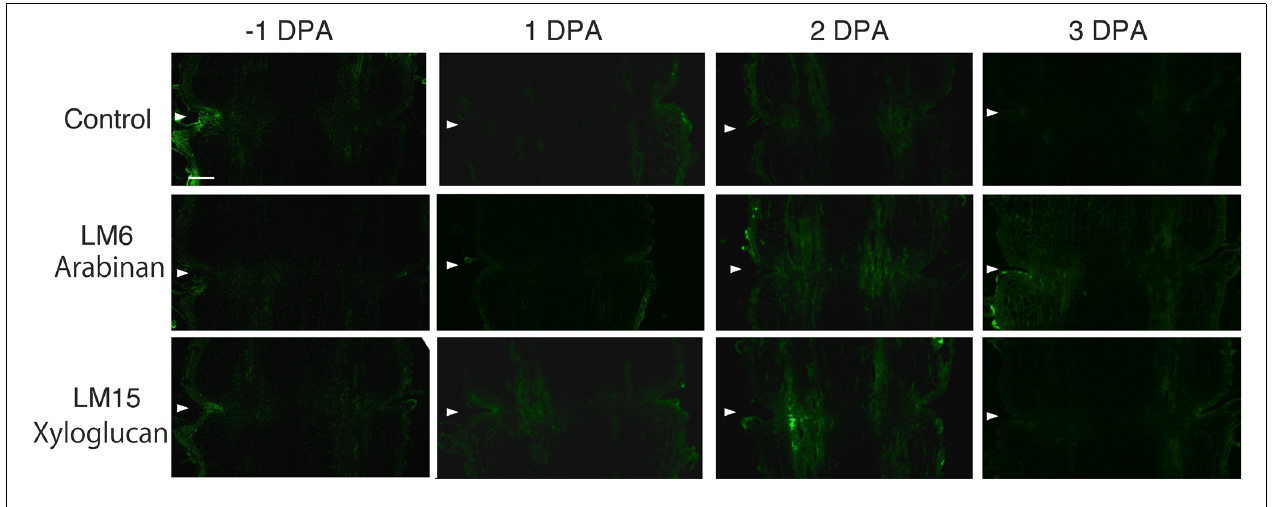
FIGURE 2 | Immunolocalization of arabinan and xyloglucan epitopes in the AZs of (cid:0) 1 DPA to 3 DPA pollinated flower pedicels. Pollination allowed the pedicel and AZ to enlarge and strengthen in adhesion. Longitudinal sections of (cid:0) 1 DPA flower